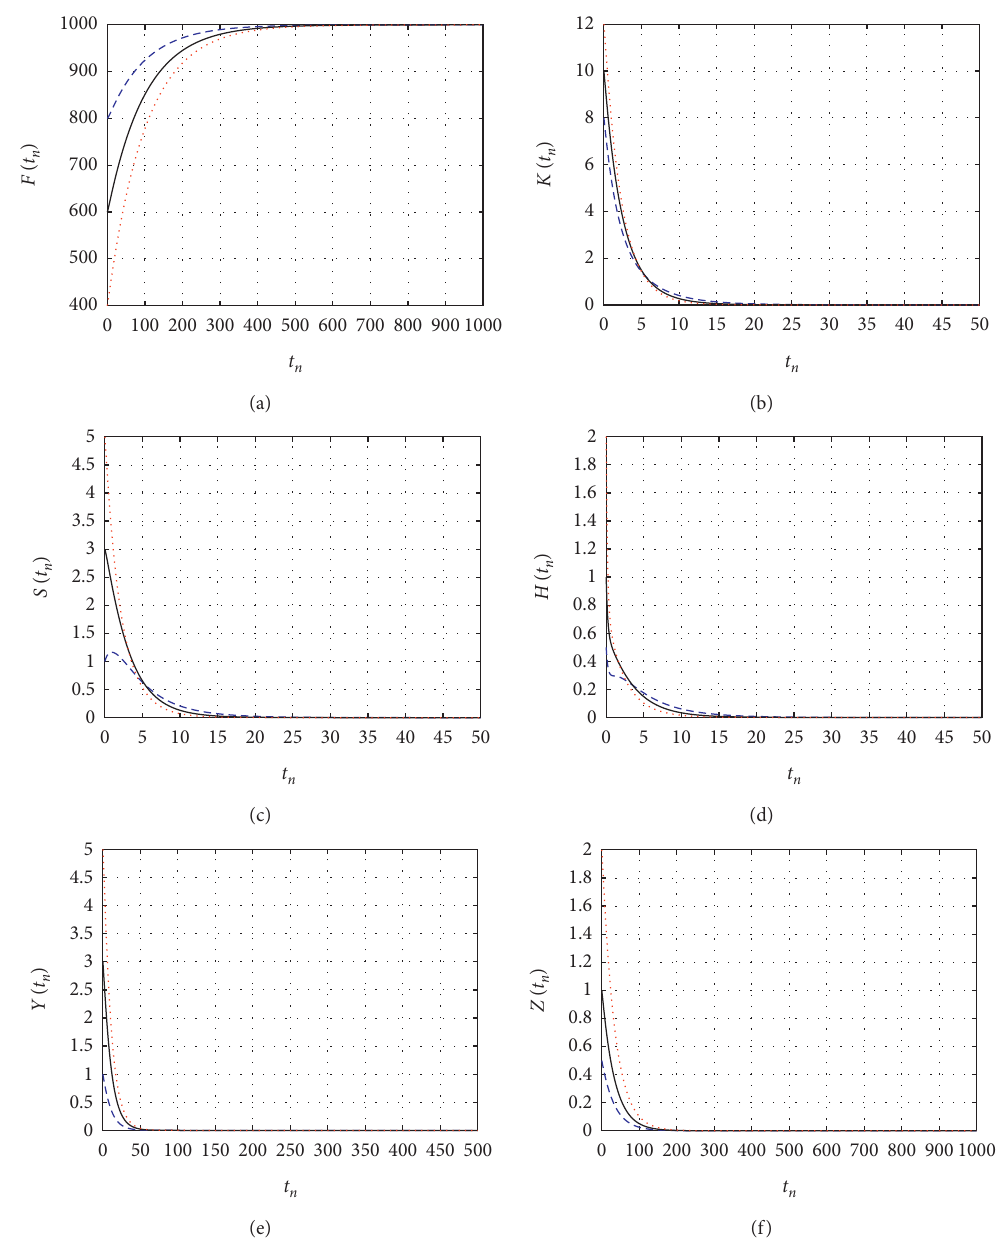
Figure 1: The solutions of systems (12)–(17) for case R